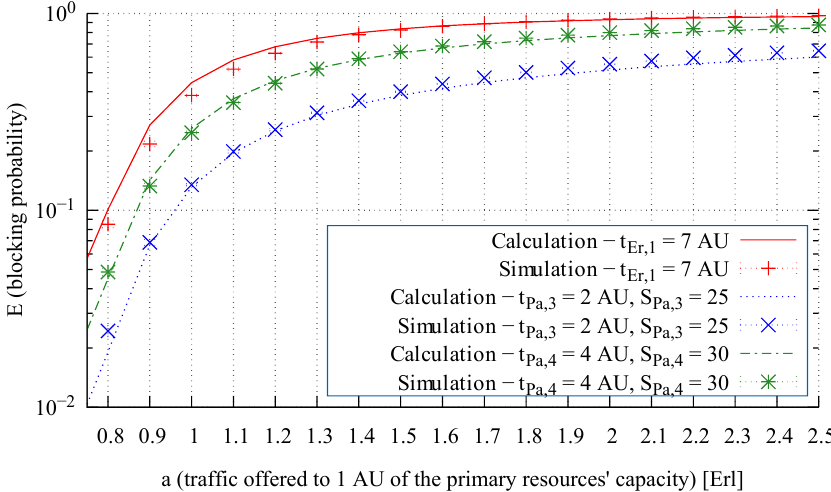
Figure 8. Blocking probability of particular traffic classes in the alternative resources of System 2.